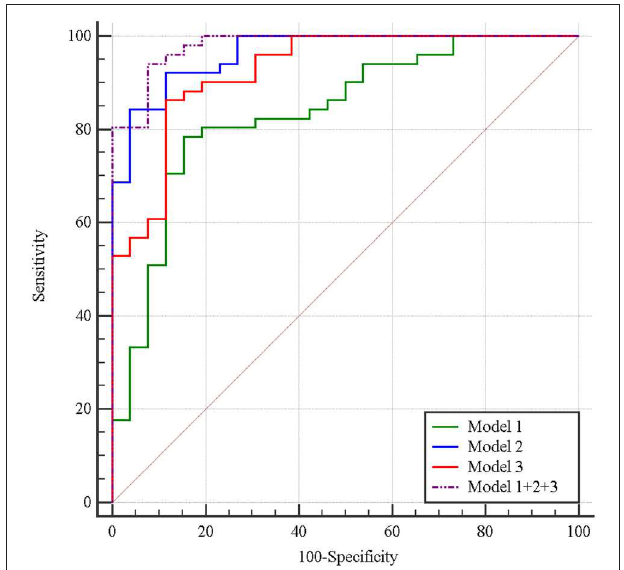
FIGURE 7 | Receiver operating characteristic curves of imaging feature-based (Model 1), texture feature-based models in arterial phase (Model 2), and portal phase (Model 3), and the combined model (Model 1 + 2 + 3) in differentiating MFP from PDAC. The areas under the curve were 0.84, 0.96, 0.93, and 0.98, respectively.